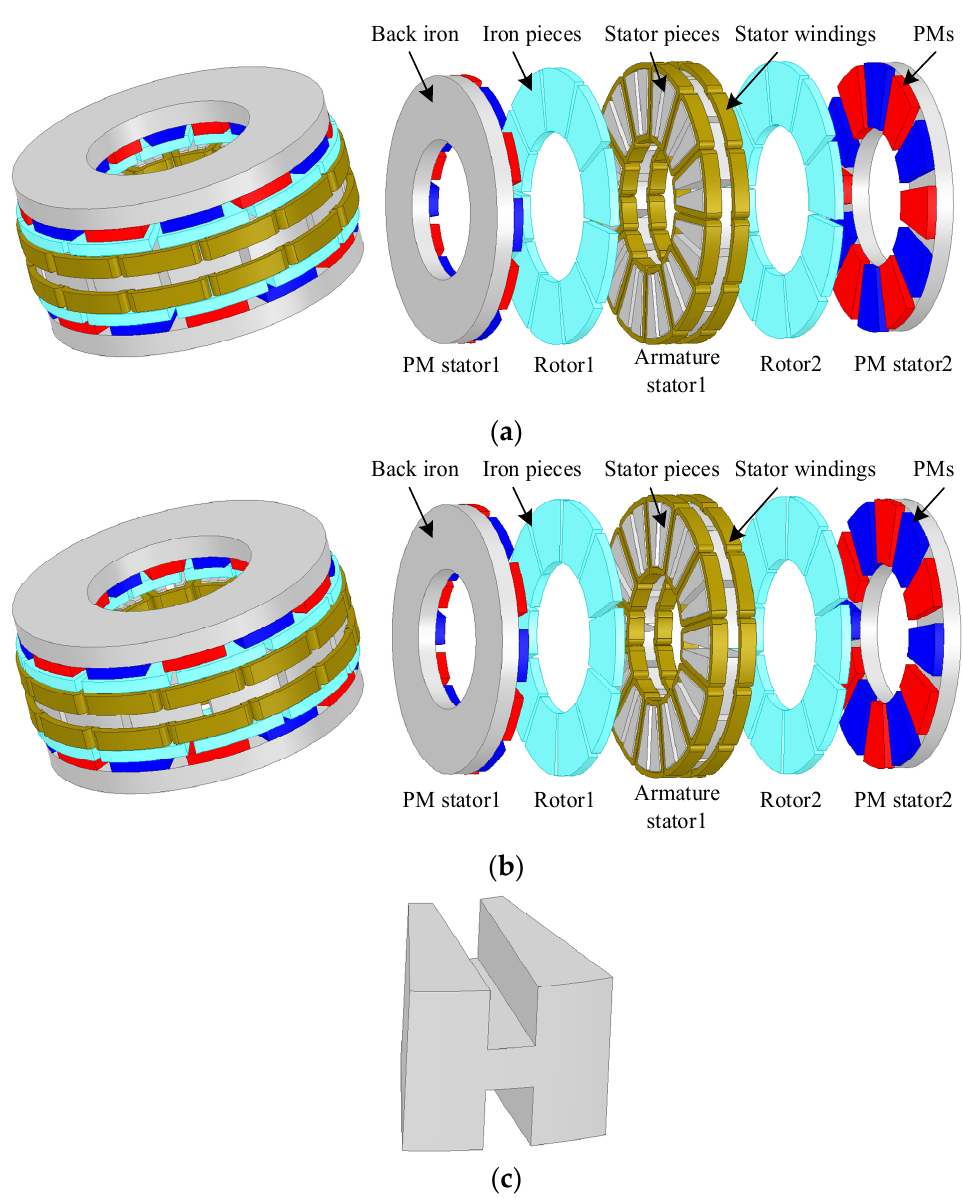
Figure 1. Proposed machine configurations: ( a ) NS type configuration; ( b ) NN type configuration; ( c ) H iron piece.